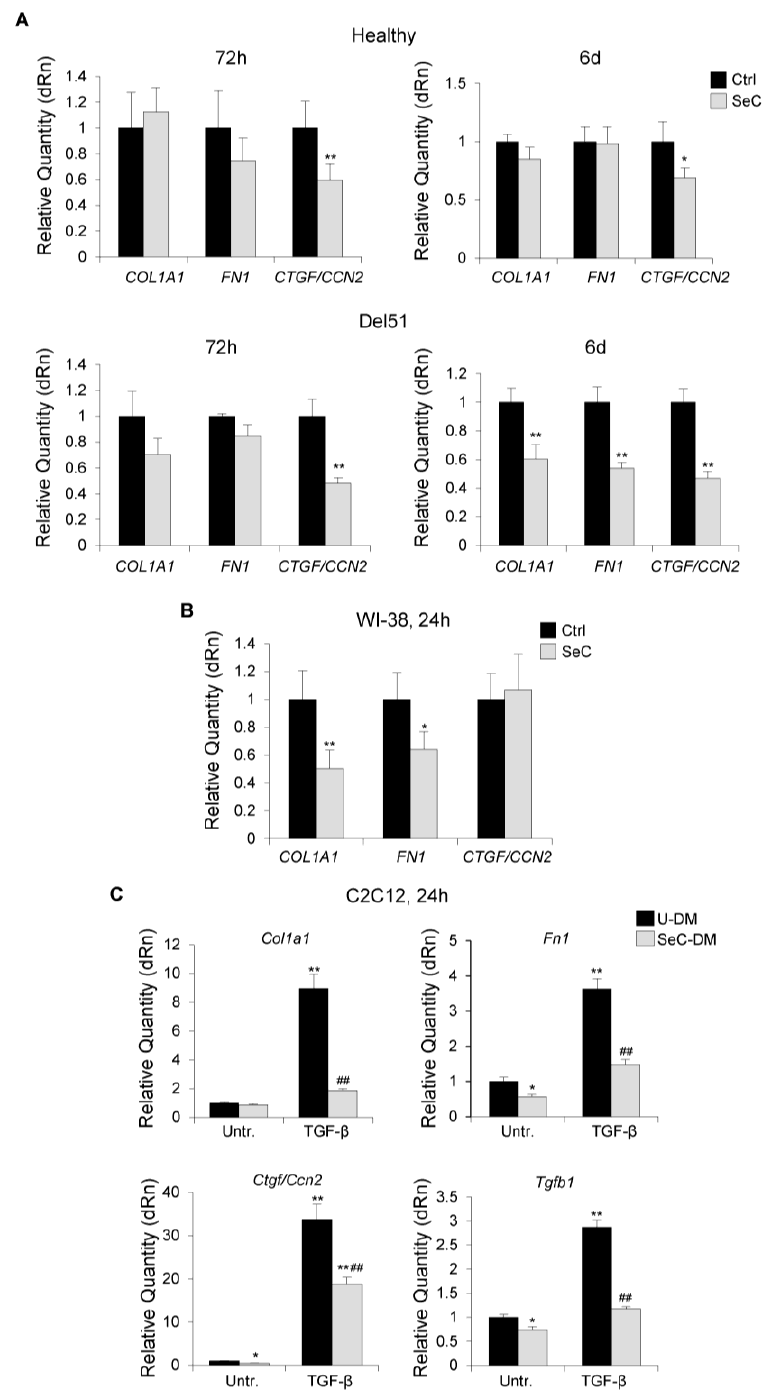
Figure 6. SeC restrain the fibrogenic potential of fibroblasts and inhibit fibrogenic transdifferentiation of myoblasts. ( A , B ) Human myoblasts derived from healthy donor and Del51 patient ( A ) or human WI-38 fibroblasts ( B ) were co-cultured in DM with (SeC) or without (Ctrl) freshly-isolated SeC (2.0 × 10 5 SeC/mL) using 0.4 µ m BD transwells at the indicated times. Cells were lysed and analyzed for the expression of the fibrogenic markers, COL1A1 , FN1, and CTGF / CCN2 by real time-PCR. ( C ) C2C12 myoblasts cultured in SeC-conditioned (SeC-DM) or unconditioned (U-DM) medium were induced to transdifferentiate into myofibroblasts by treatment with TGF- β (5 ng/mL) for 24 h. Cells were lysed and analyzed for the expression of Col1a1 , Fn1 , Ctgf / Ccn2 , and Tgfb1 by real time-PCR. Reported are the means ( ± SD) of three independent experiments with respect to control (Ctrl) normalized for GAPDH ( A , B ) or Gapdh ( C ) used as house-keeping genes. * and **, significantly different from Ctrl or untreated U-DM (Untr.) ( p < 0.05 and p < 0.01, respectively); ##, significantly different from TGF-β-treated U-DM ( p < 0.01).